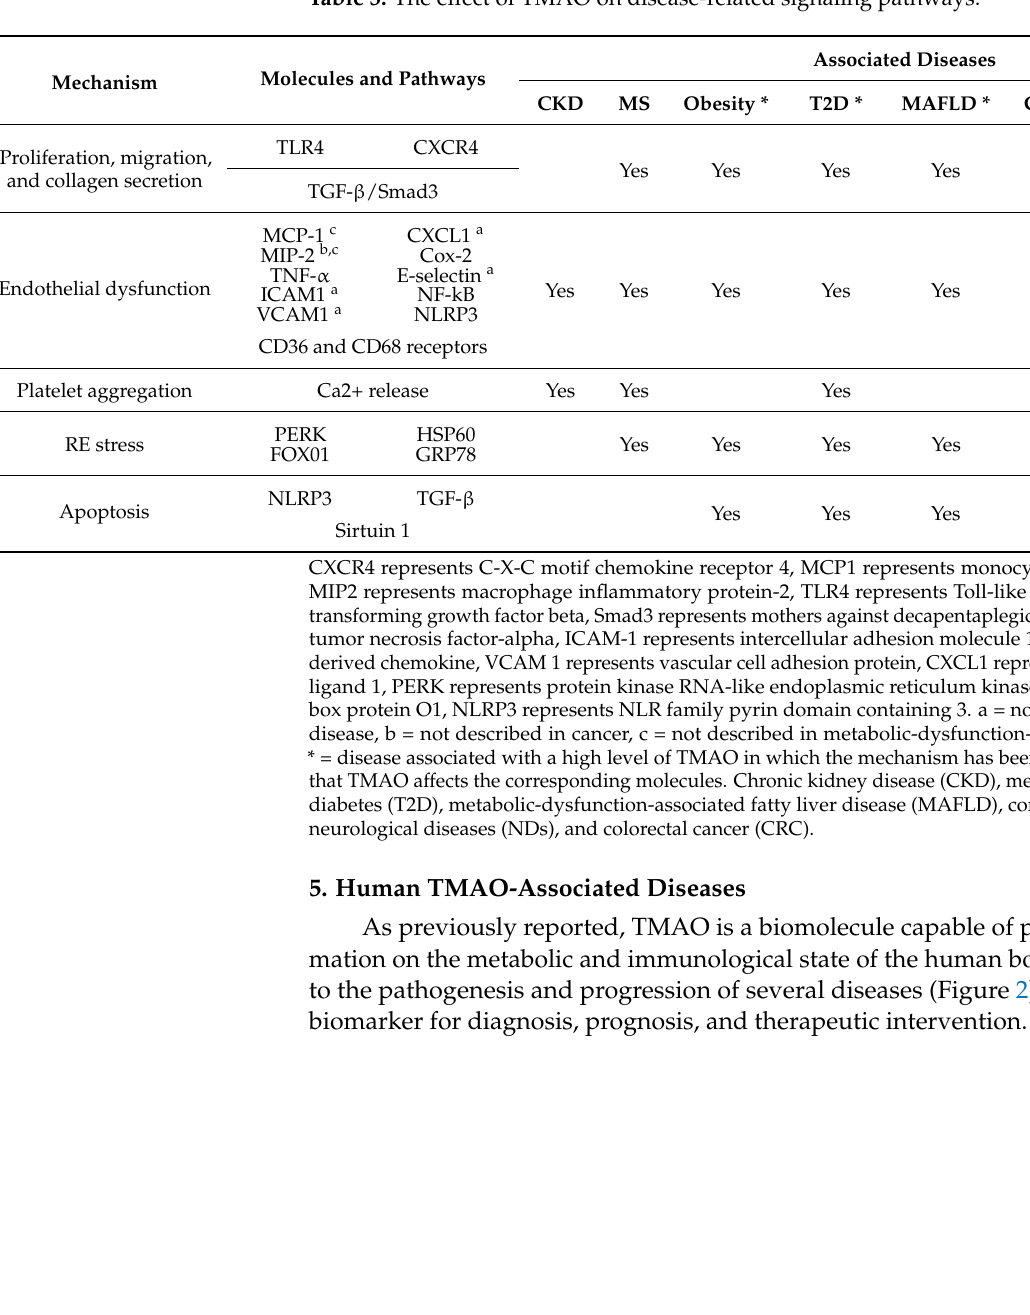
Table 3. The effect of TMAO on disease-related signaling